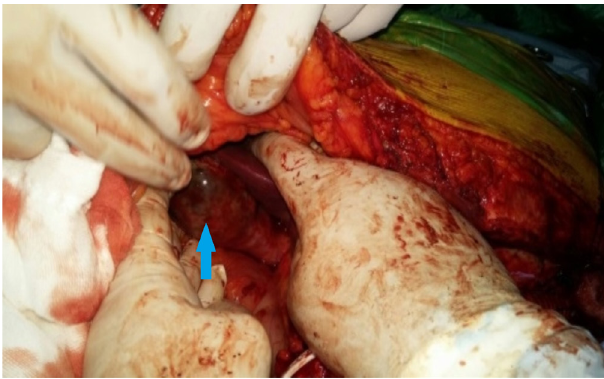
Fig. 2 - Ischemic hydropic gallbladder with necrosis.